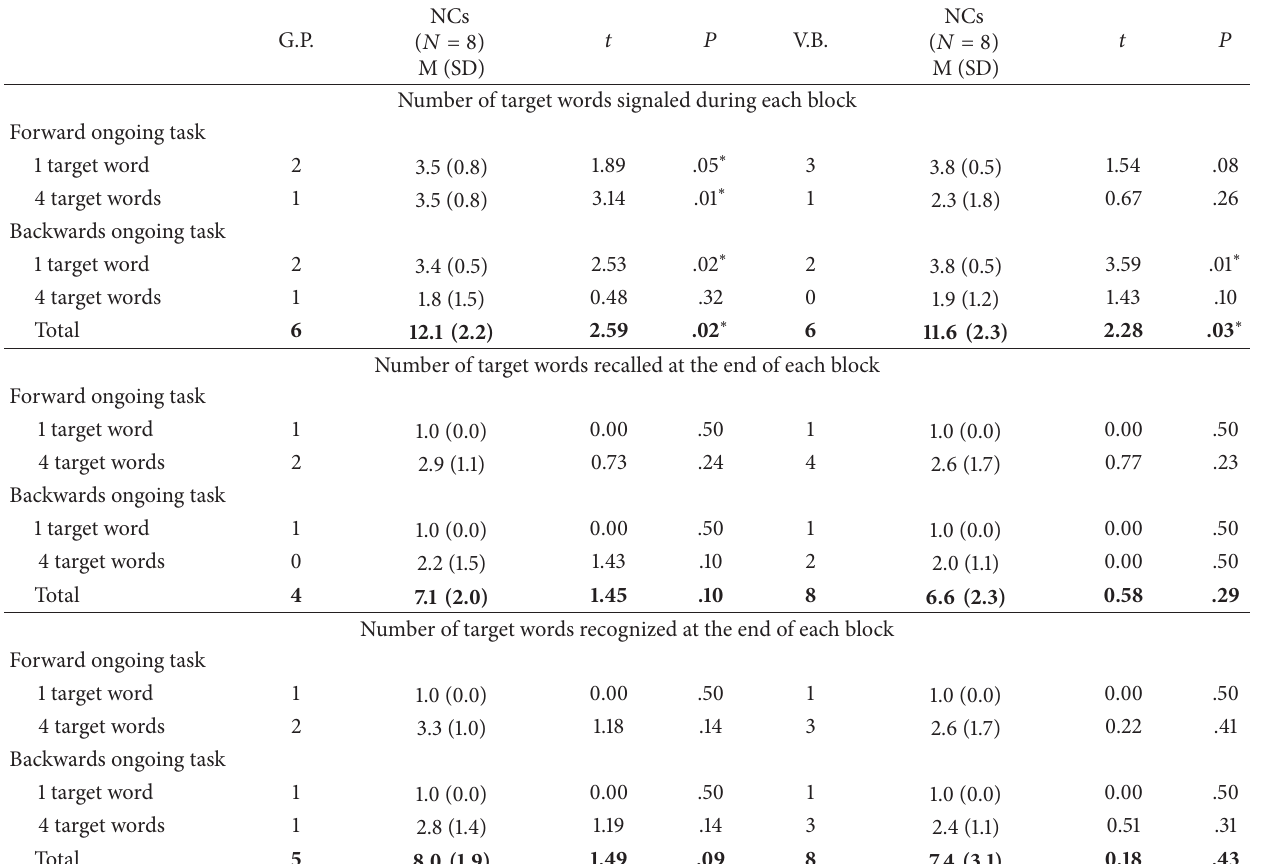
Table 3: Performance scores of G.P. and V.B. on the event-based PM task. 𝑡 -tests for significant differences of individual scores from average scores of groups of normal controls are also